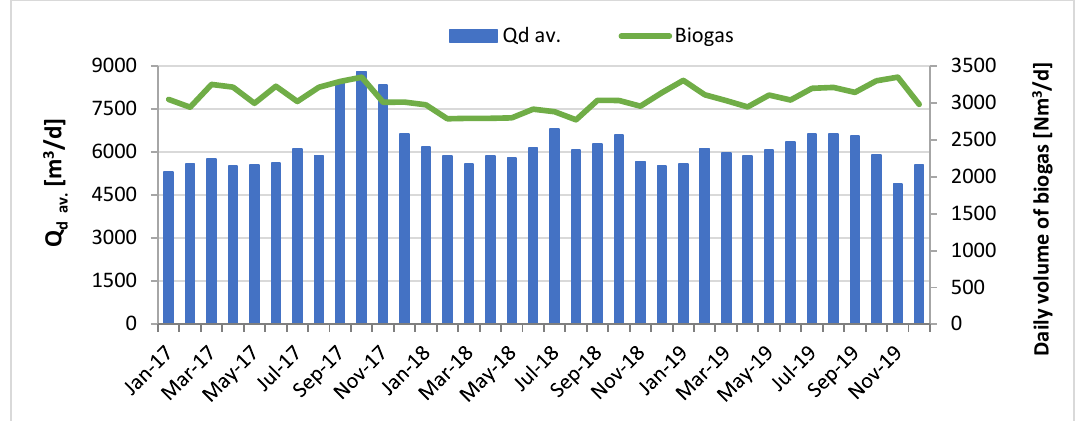
Figure 9. Daily biogas production vs. the wastewater flow in the WWTP.